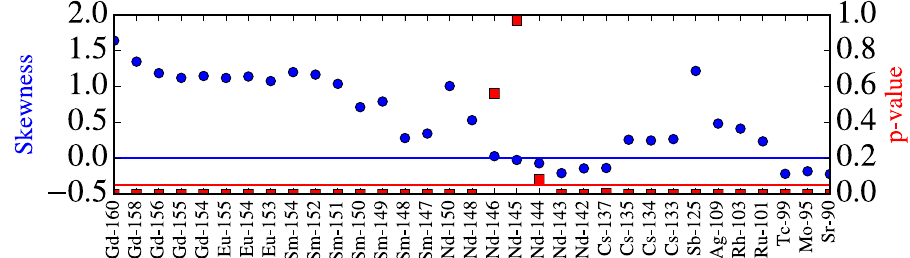
Fig. 3. Biases and uncertainties for the FP concentrations of U1 after applying MLO. C values were taken as the mean of the distribution.